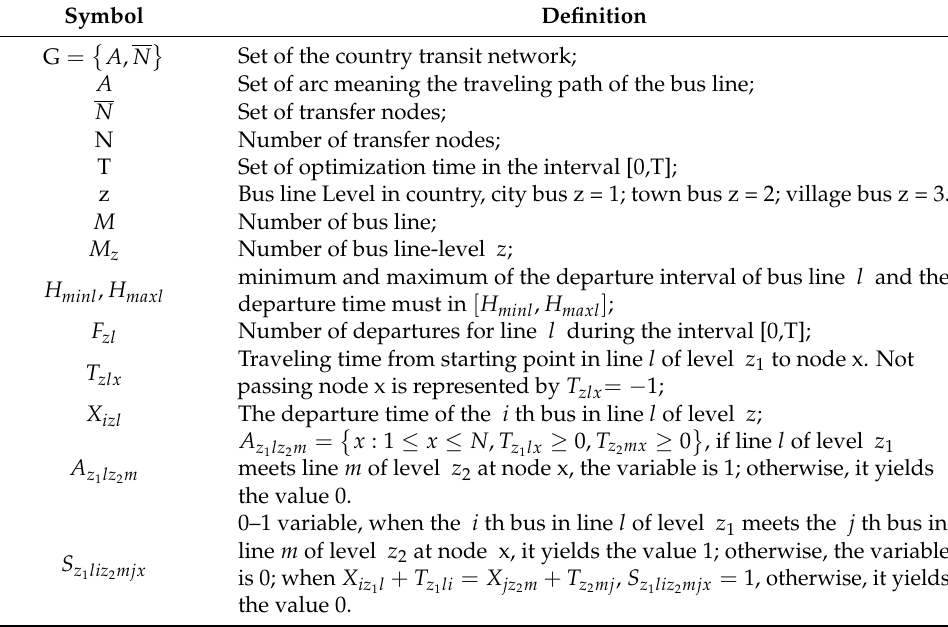
Table 2. Notation Table 2. Notation definitions.